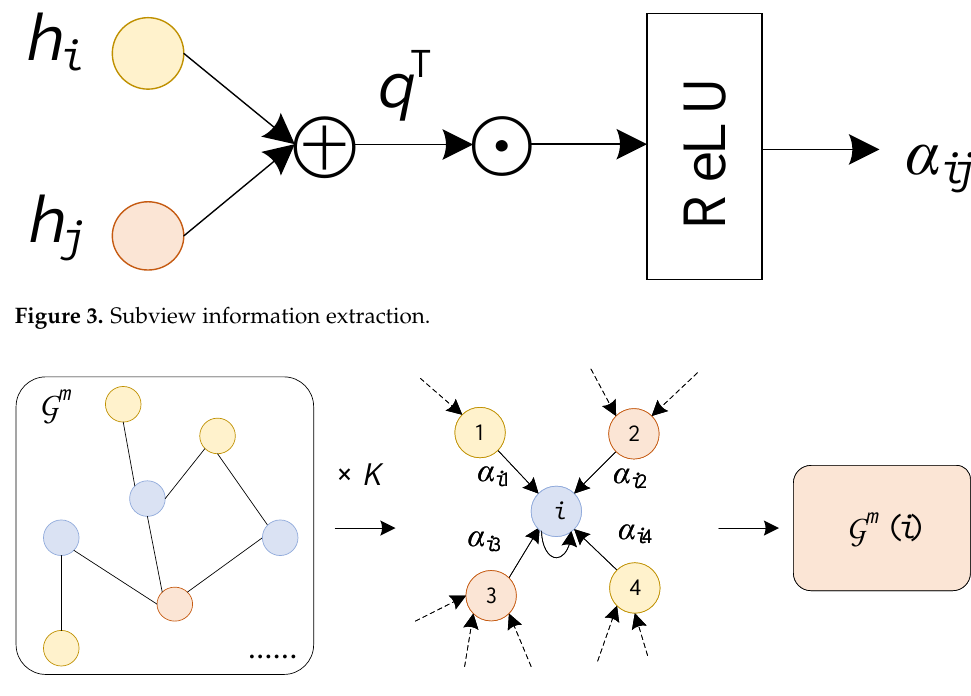
Figure 4. Calculation of normalized attention value α ij